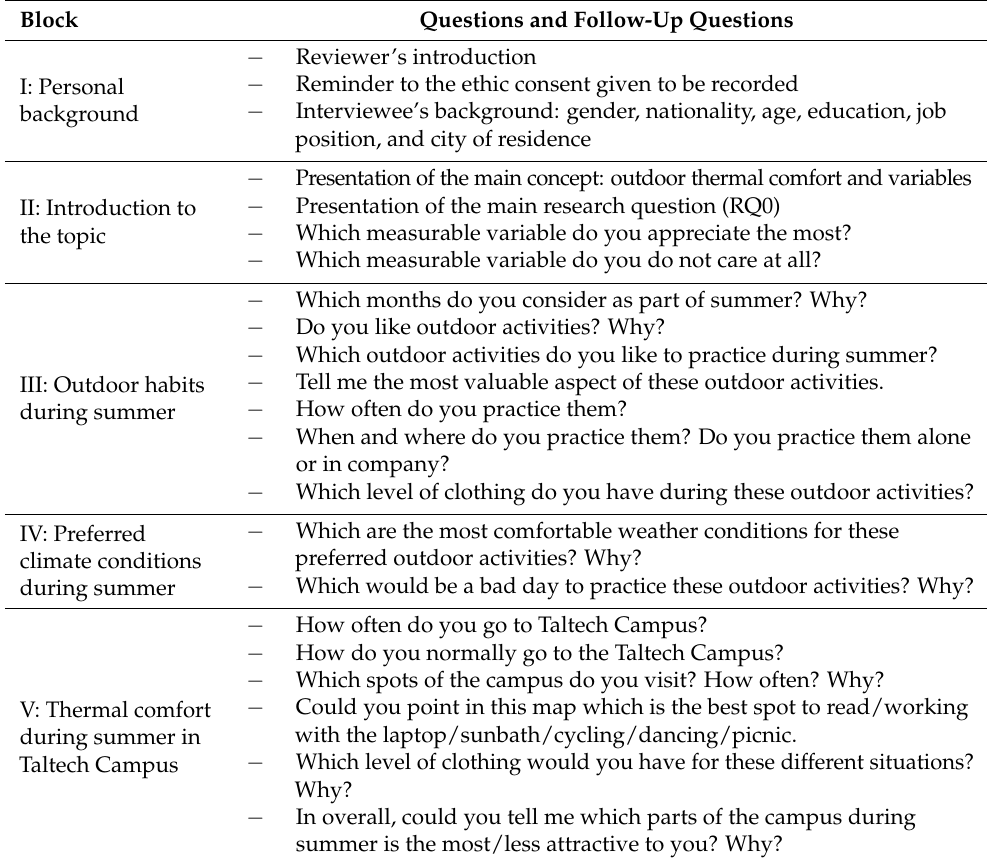
Table 2. Definition of question blocks used for the